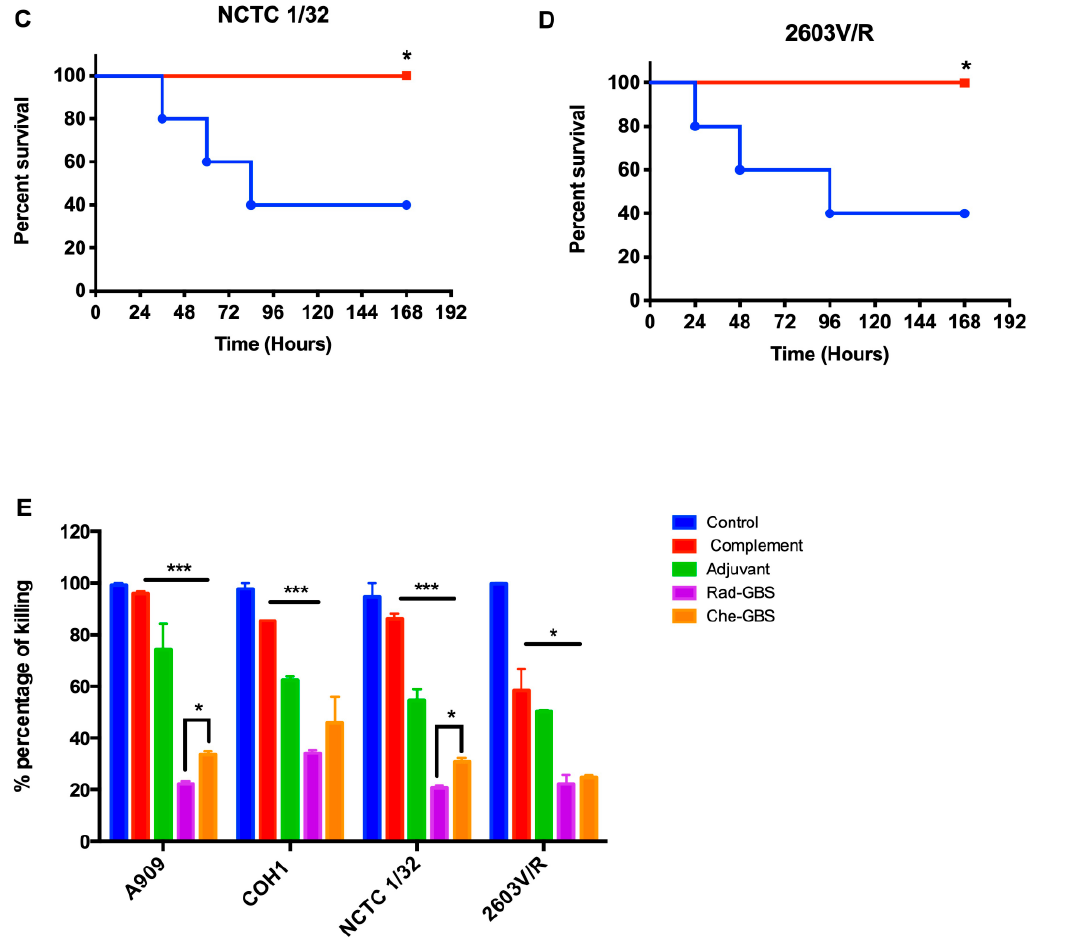
Figure 7. Cross-reactive protection highly induces functional antibodies against multiple serotypes via Rad-GBS vaccination. Mice ( n = 5) were vaccinated intramuscularly with 10 7 CFU of Rad-GBS supplemented with alum (20 µ g), and the cohort was administrated PBS as a control. Mice were challenged intravenously with a lethal dose of GBS strains ( A ) A909 (Ia), ( B ) COH1 (III), ( C ) NCTC 1/32 (IV), and ( D ) 2603VR (V) at 7 days after the last immunization. Survival of the mice was observed and recorded for one week. ( E ) Opsonic killing activity of the sera isolated from Rad-GBS- or Che-GBS-immunized mice against multiple serotypes of GBS strains (A909, COH1, NCTC1/32, and 2603V/R) was examined. The differentiated HL-60 cells (4 × 10 6 cells) and 10 µ L of baby rabbit complement were added into the mixed suspension of the diluted sera (1:500) isolated from the immunized mice and bacteria, while the negative control group contained only differentiated HL-60 cells and heat-inactivated baby rabbit complement. All data were expressed as the means ± standard deviation per group. The survival of mice was determined using Kaplan–Meier survival analysis, and the significance of the difference was analyzed using a log-rank test. *** Stands for p < 0.001, ** stands for p < 0.01, * stands for p < 0.05, and NS for not significant.